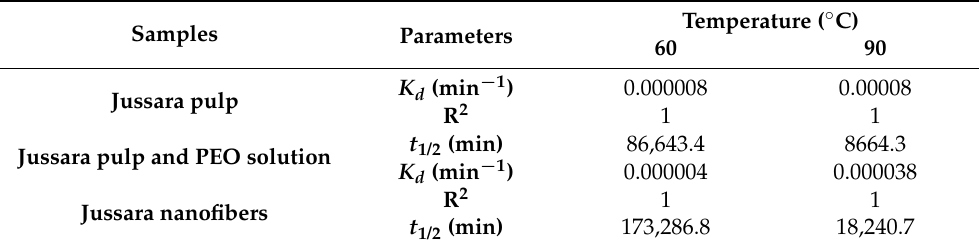
Table 3. Degradation rate constants ( K d ) and the respective correlation coefficients (R 2 ) and half-life values ( t 1/2 ) of the jussara pulp, jussara pulp and PEO solution, and jussara nanofibers for each temperature studied.